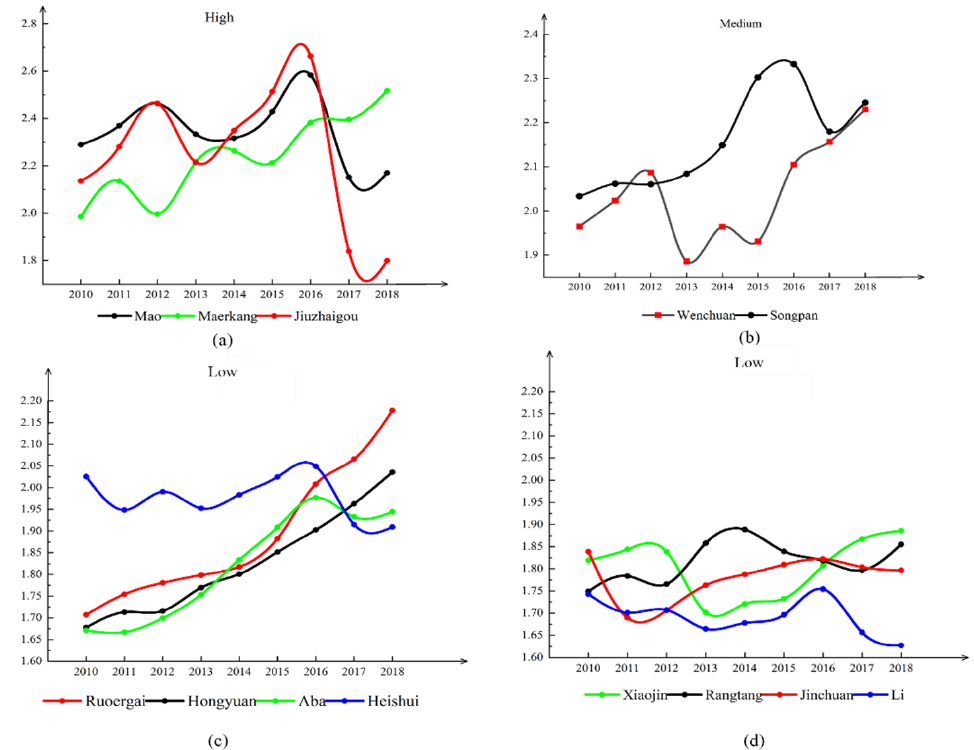
Figure 4. Changes in resilience in 13 areas. ( a ) high resilience regions; ( b ) medium resilience regions; ( c , d ) low resilience regions.